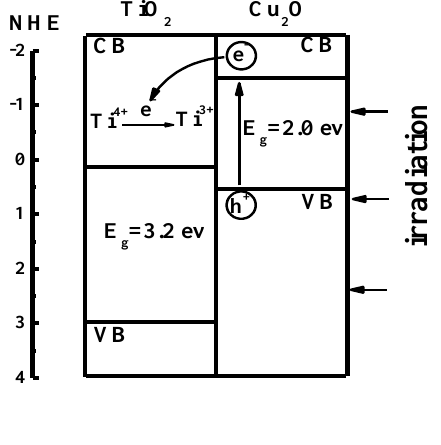
/Cu O bilayer film 2 2